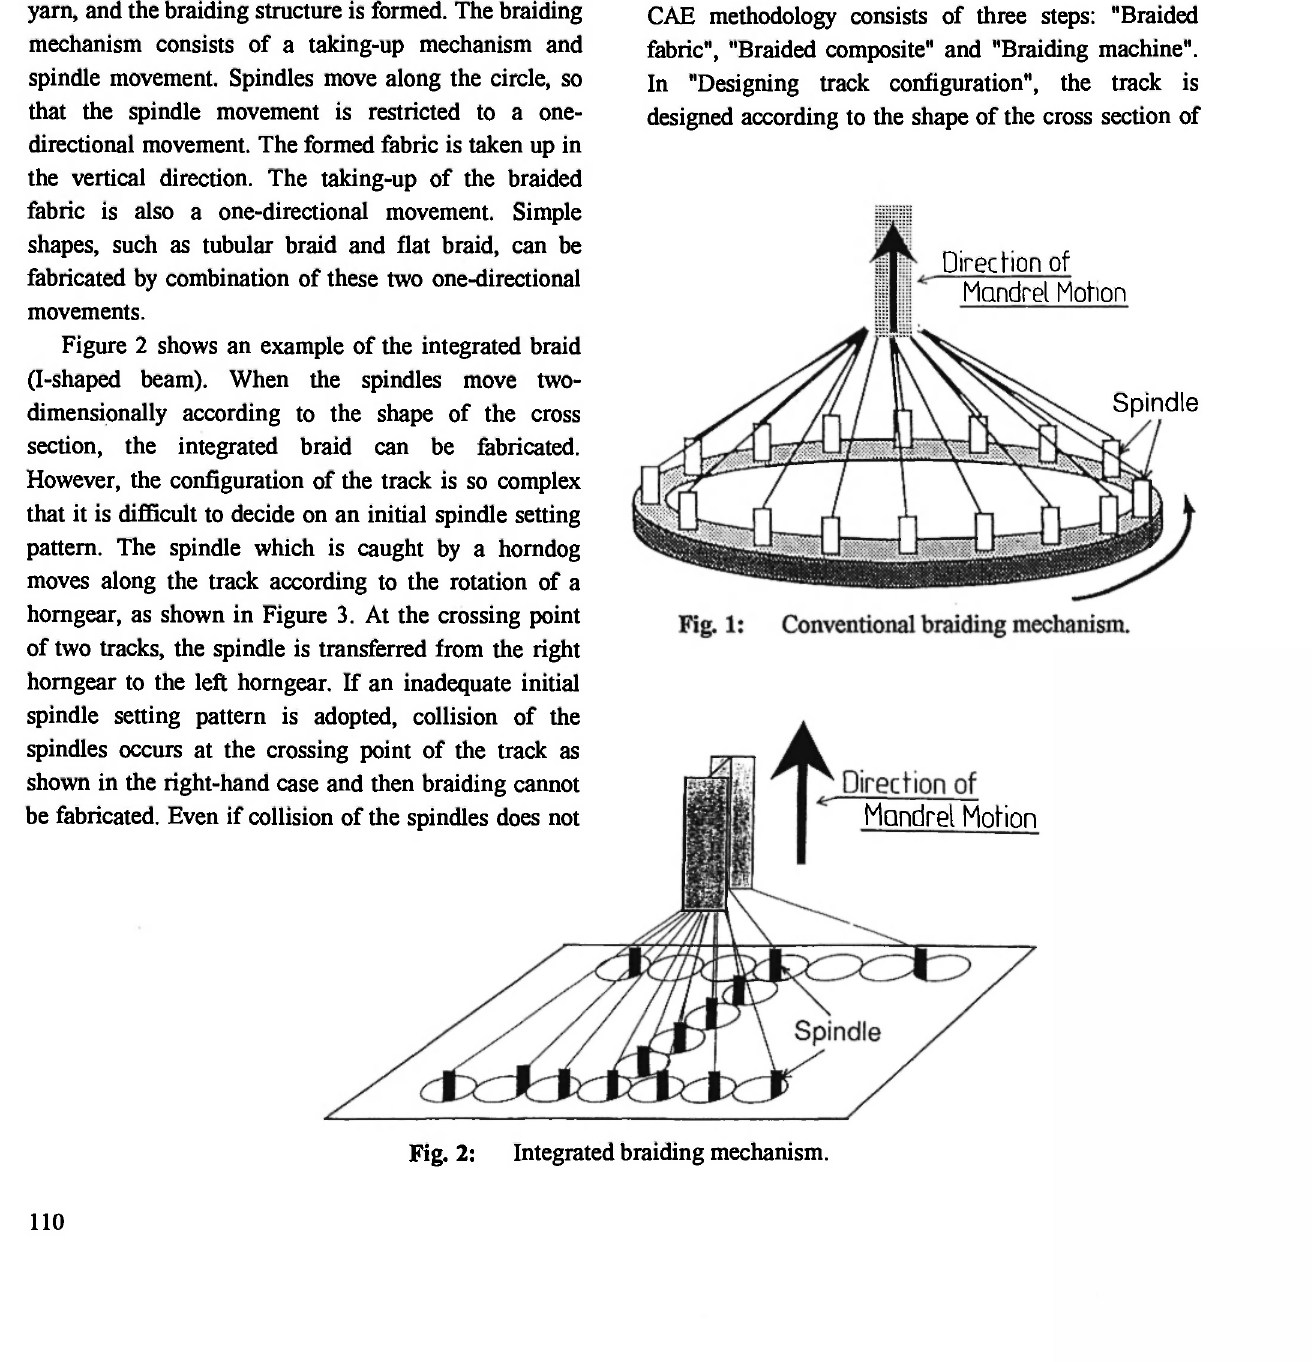
3. CAE METHODOLOGY FOR THE INTE- GRATED BRAIDED COMPOSITE 4 shows the CAE methodology for